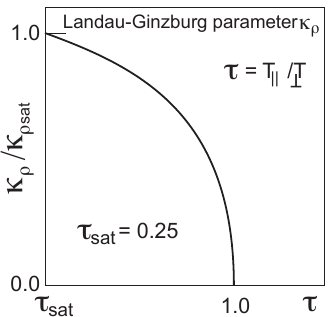
Figure 1. Shape of excess density in dependence on x/ shape of the magnetic field depression can be obtained directly from pressure balance. It mirrors the excess density.